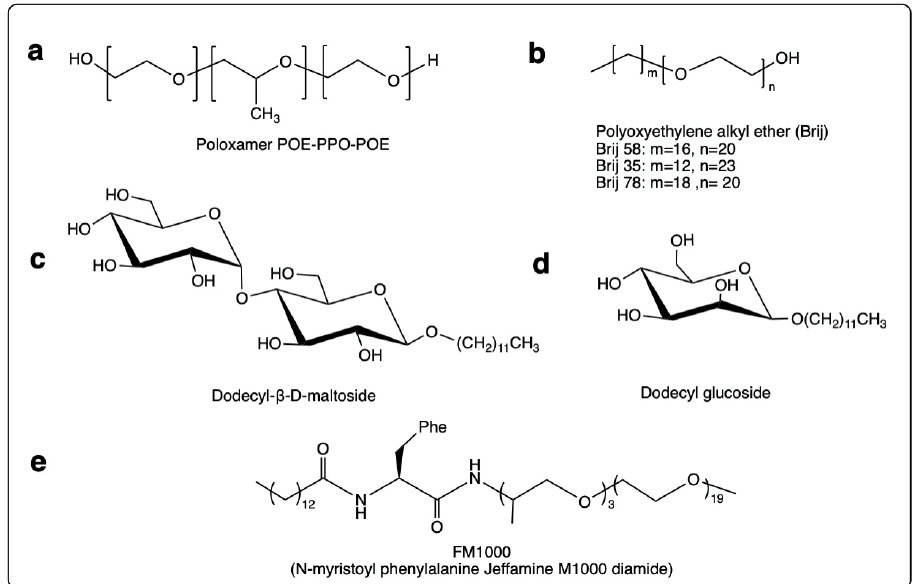
Figure 2. Chemical structures of potential surfactant PS alternatives devoid of an ester bond: (a) Poloxamer, (b) Polyoxyethylene alkyl ether (Brij), (c) Dodecyl- β -D-maltoside, (d) Dodecyl gluco- side, and (e) N-myristoyl phenylalanine Jeffamine M1000 diamide (FM1000).